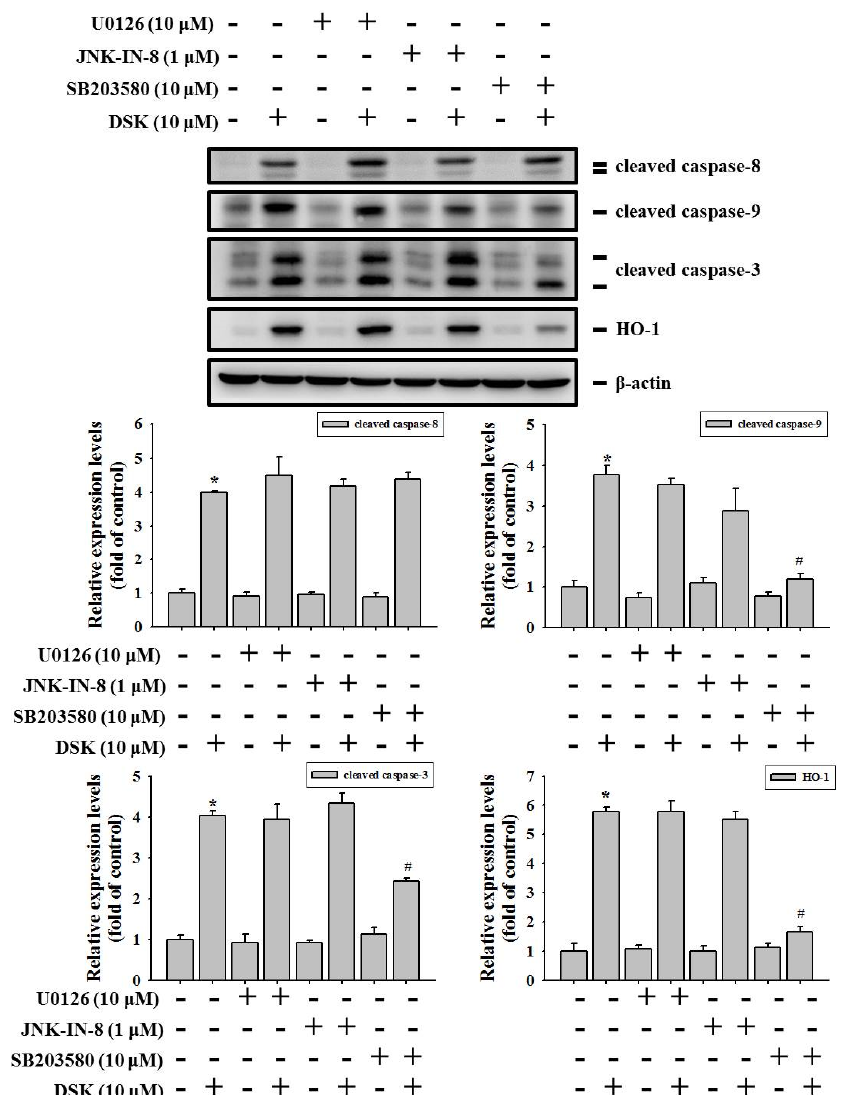
Figure 7. p38-MAPK mediates HO-1 induction and caspase activation in DSK-treated tongue cancer. HSC-3 cells were pretreated with indicated kinase inhibitors for 2 h and then treated with DSK for additional 24 h, followed by assessment for the levels of caspase cleavage and HO-1 expression by immunoblotting with indicated antibodies. Densitometric analyses were quantified and normalized with internal controls ( β -actin). Data represent the average ± SD of three independent experiments. * p < 0.05 compared with untreated controls using Student’s t -test. # p < 0.05 compared with DSK-